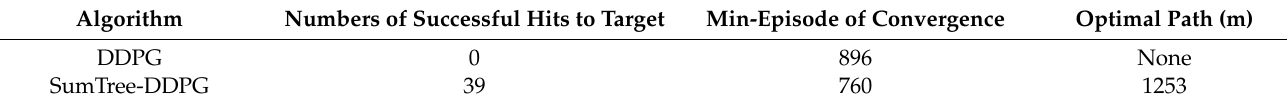
Table 7. Performance evaluation in the training environment 2 over 1000 episodes.